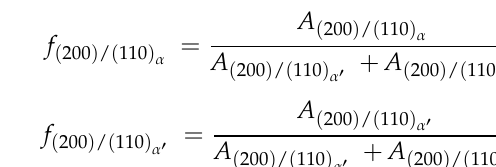
peak, and fraction of ( c ) α phase and ( d ) α’ phase. α’